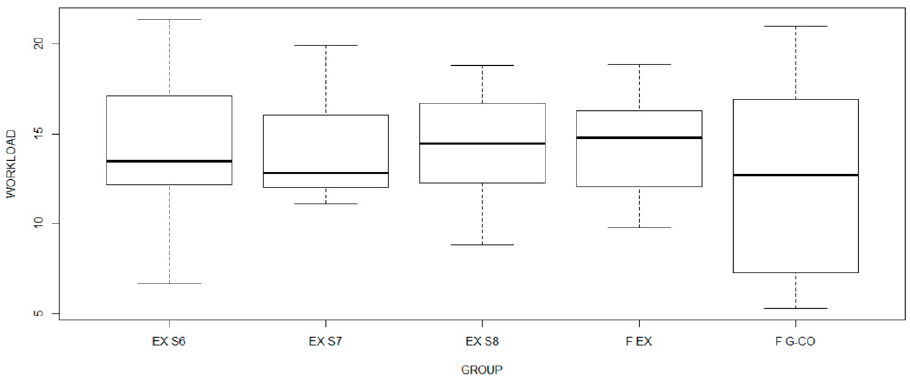
Figure 7. Box plots of the control group and the experimental group in the last three sessions and the final session.